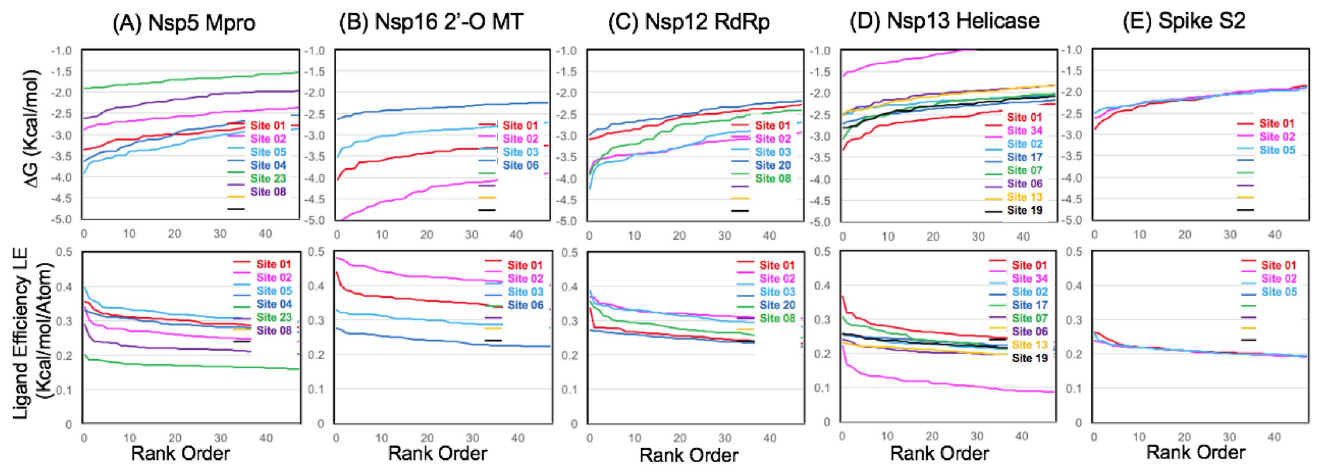
Fig 5. Ligand efficiency comparisons from computational fragment screening. Data is shown on the same Y-axis scale for free energy ( Δ G bind ) and ligand efficiency comparing numerous sites on different target proteins using the FRAG100 library as a benchmark: (A) Nsp5 Mpro (B) Nsp16 2’-O MT (C) Nsp12 RdRp (D) Nsp13 Helicase (E) S2